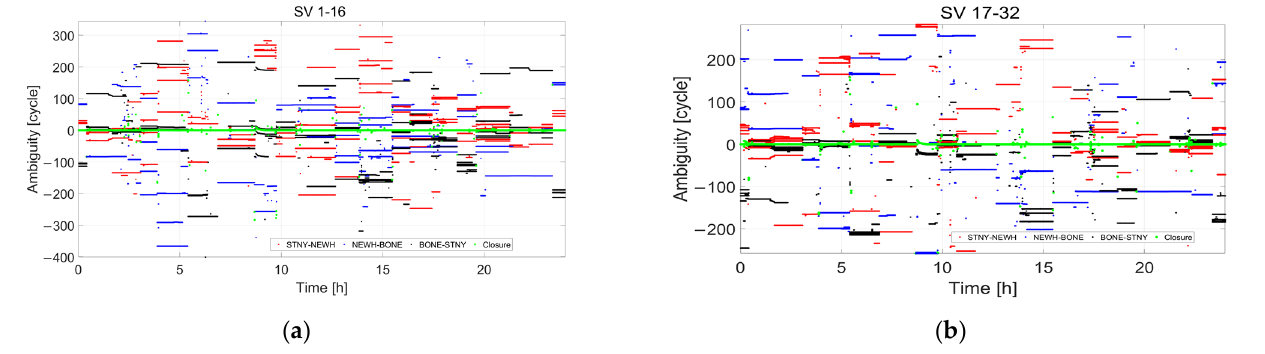
Figure 10. ∇ ∆ N closure in the network. ( a ) ∇ ∆ N closure for SV1-SV16; ( b ) ∇ ∆ N closure for SV17-SV32.